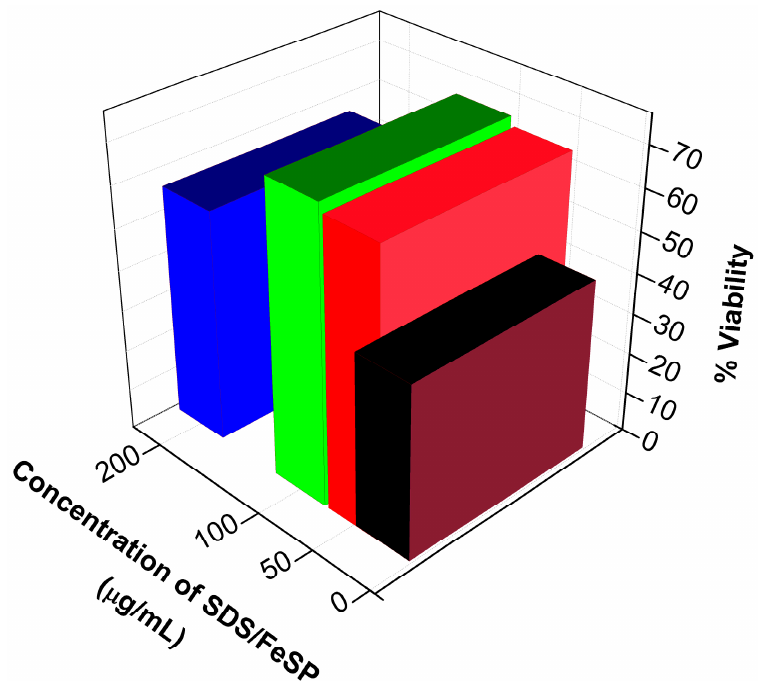
Figure 8. Viability effect with the increase in concentration of SDS/FeSP nanocomposites.